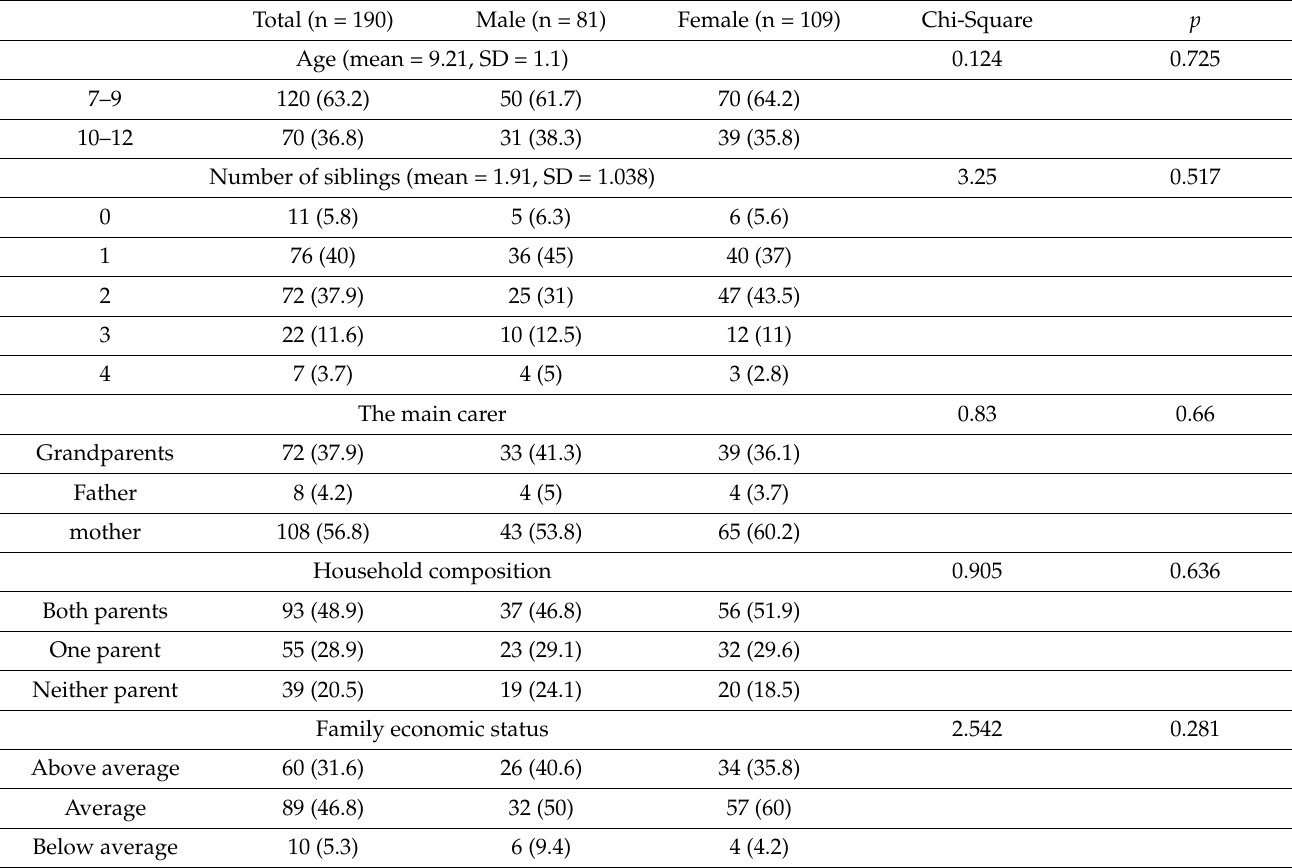
Table 2. Sociodemographic and background information of participants at Assessment